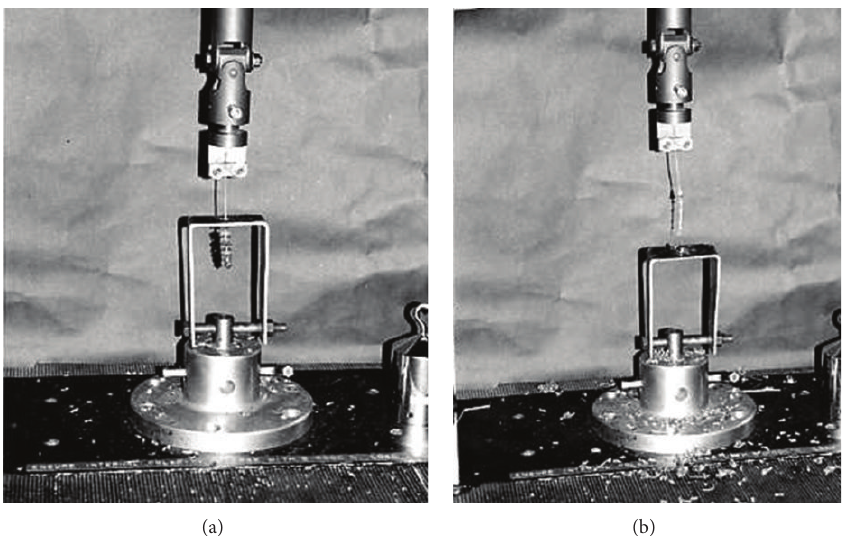
Figure 1: Flower detachment force measurement using an Instron 1122 test machine. Sample placement (a) before detachment and (b) after detachment.